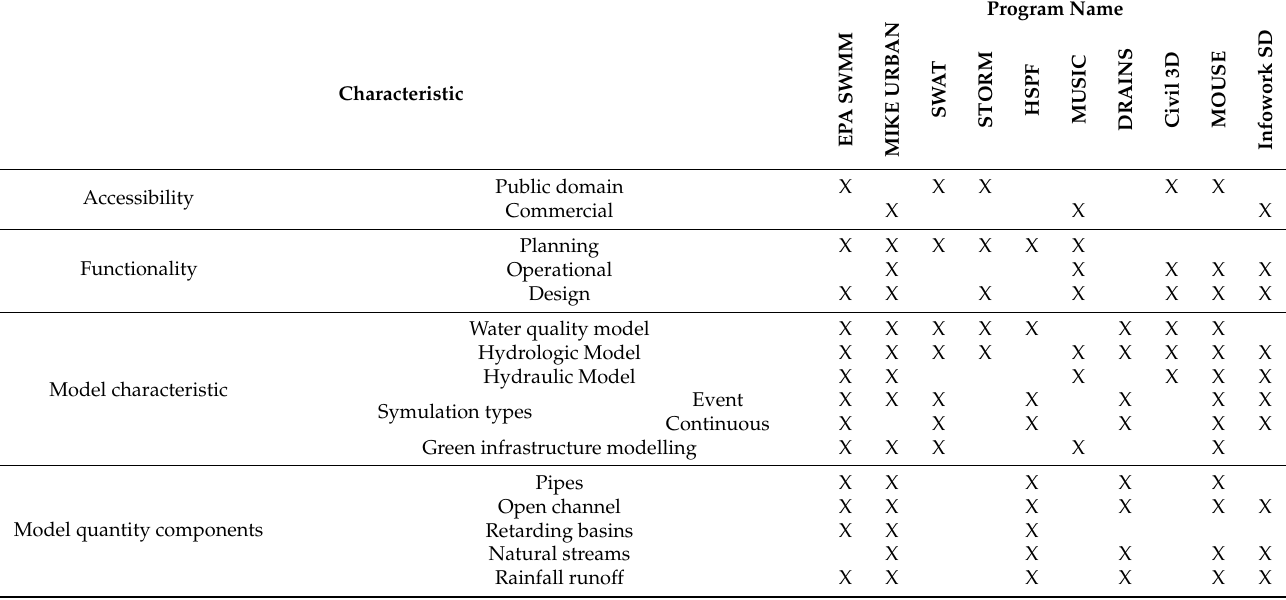
Table 1. Characteristics of the most popular rainfall-runoff modelling software, combined from